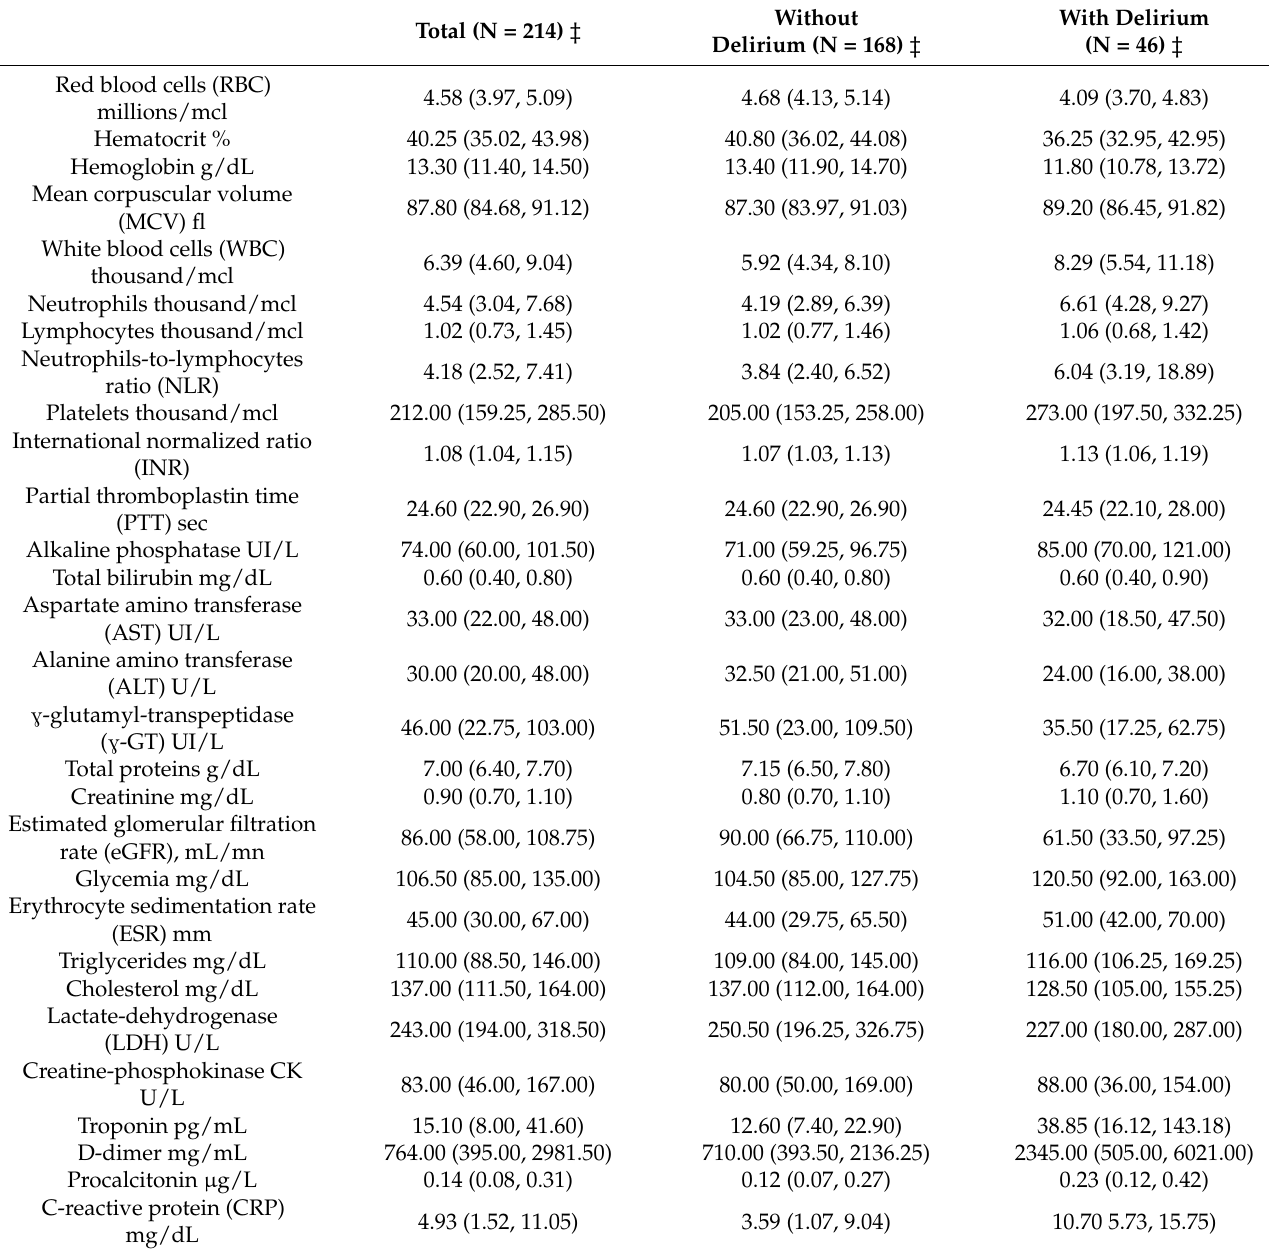
Table 2. Baseline † laboratory findings in COVID-19 patients with and without